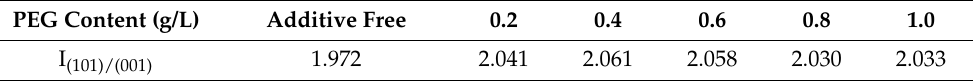
Figure 8. X-ray diffraction patterns images of as-prepared Mg(OH) 2 . ( a ) Additive free; ( b ) 0.2 g/L; ( c ) 0.4 g/L; ( d ) 0.6 g/L; ( e ) 0.8 g/L; ( f ) 1.0 g/L.